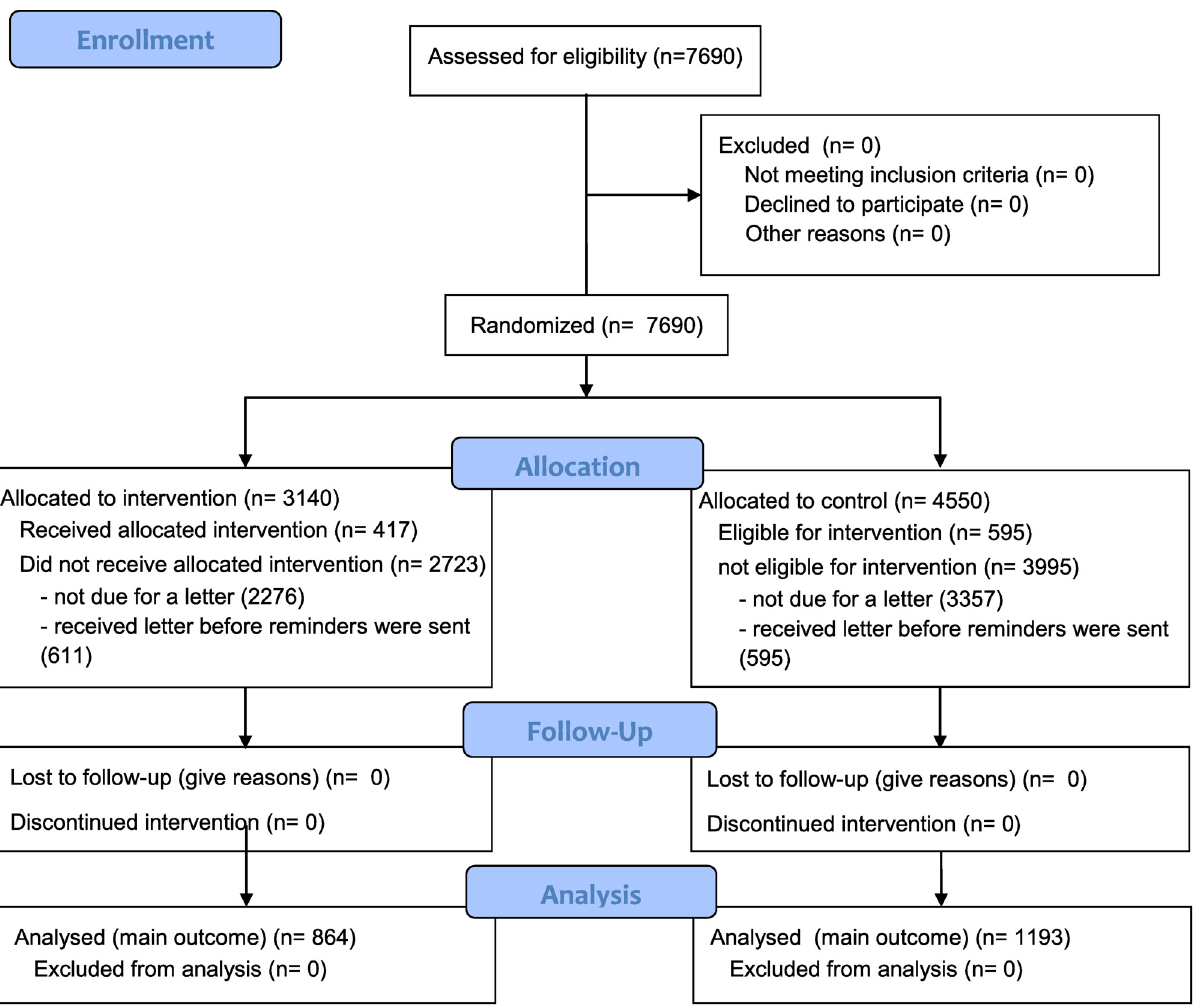
Fig 3. CONSORT diagram. All 7690patients visiting the internalmedicineor geriatrics outpatient clinic were included.Doctors allocatedto the interventiongroup receivedremindersfor patients who were due for a letter during the trial.